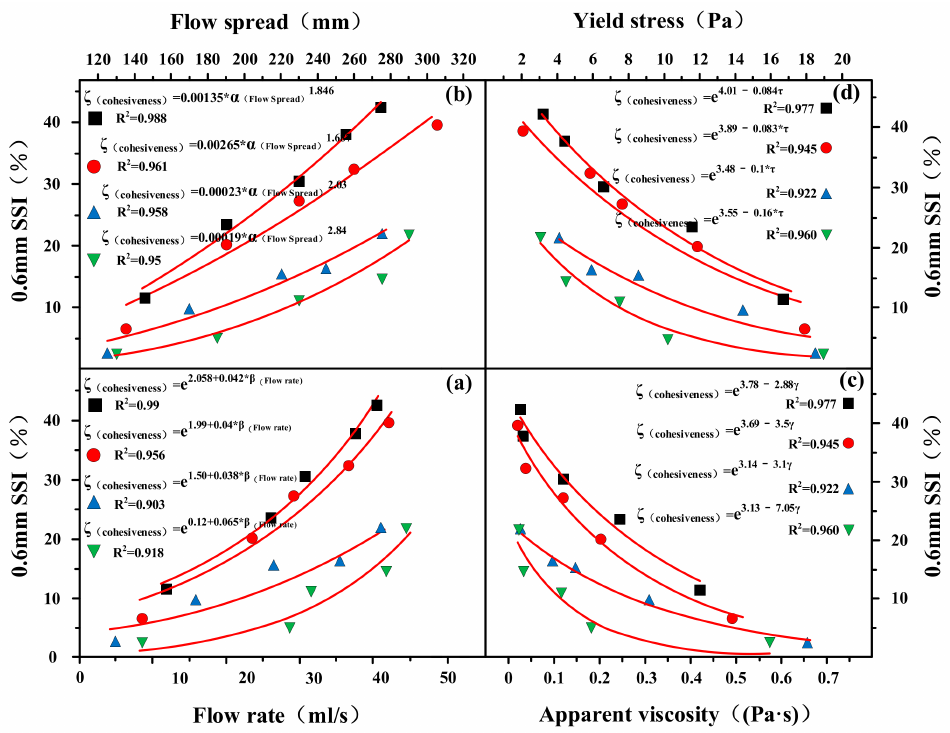
Figure 15. Flow rate ( a ), flow spread ( b ), apparent viscosity ( c ), and yield stress ( d ) versus cohesiveness. The bleeding rate and cohesiveness are shown as functions of 1 day, 7 days, and 28 days of compressive strength for SB substitutions from 5% to 20% in Figure